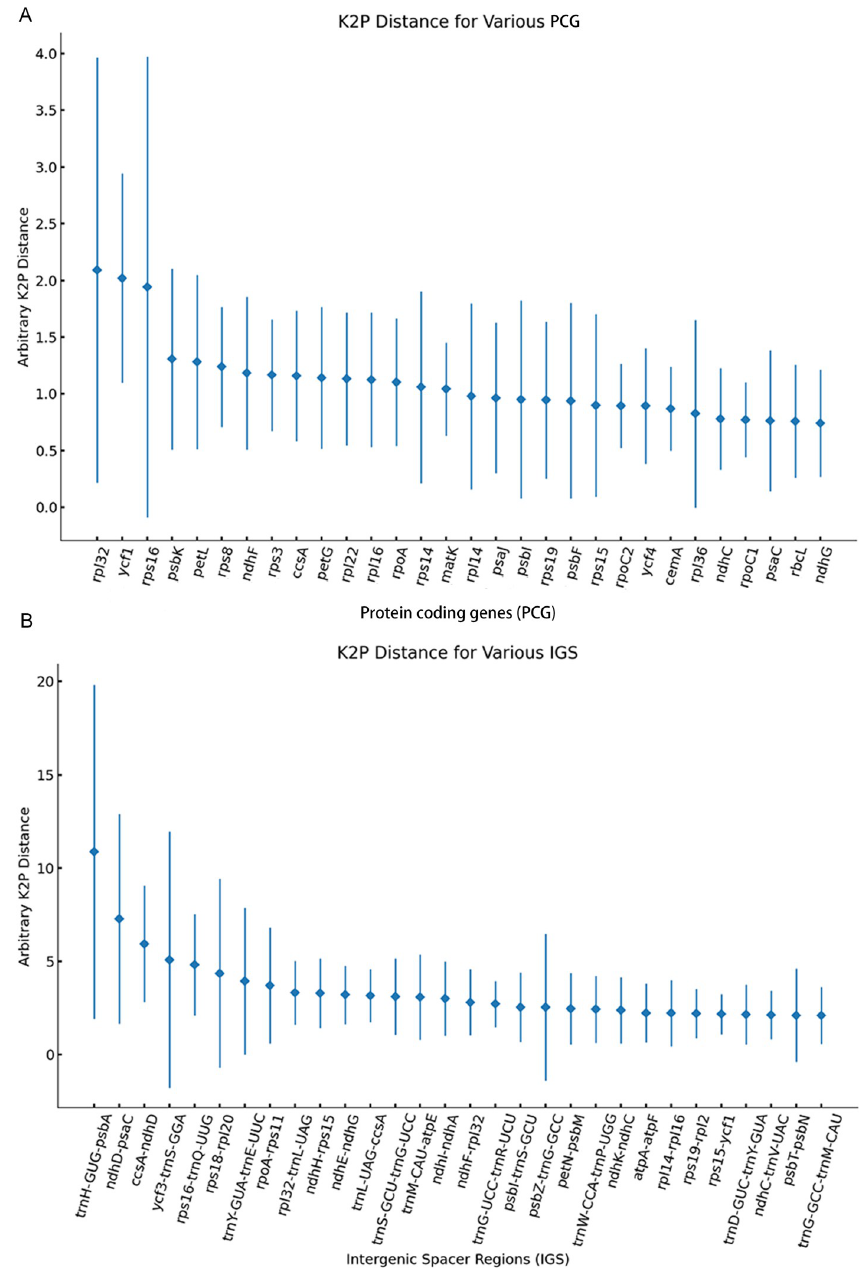
Fig 3. Results of genetic distance analysis of protein coding genes (A) and intergenic regions (B) in Clerodendrum species. Comparison of the variability of PCG and IGS regions among C . chinense , C . cyrtophyllum , C . lindleyi , C . yunnanense , C . mandarinorum , C . trichotomum , C . thomsoniae and C . japonicum . The X-axis indicates the name of PCG and IGS regions. The top thirty PCG or ICG of K2p distances were showed in panel A and panel B. And the Y- axis shows the range of K2p distances between different pairs of species. The diamond shows the average K2p distance,